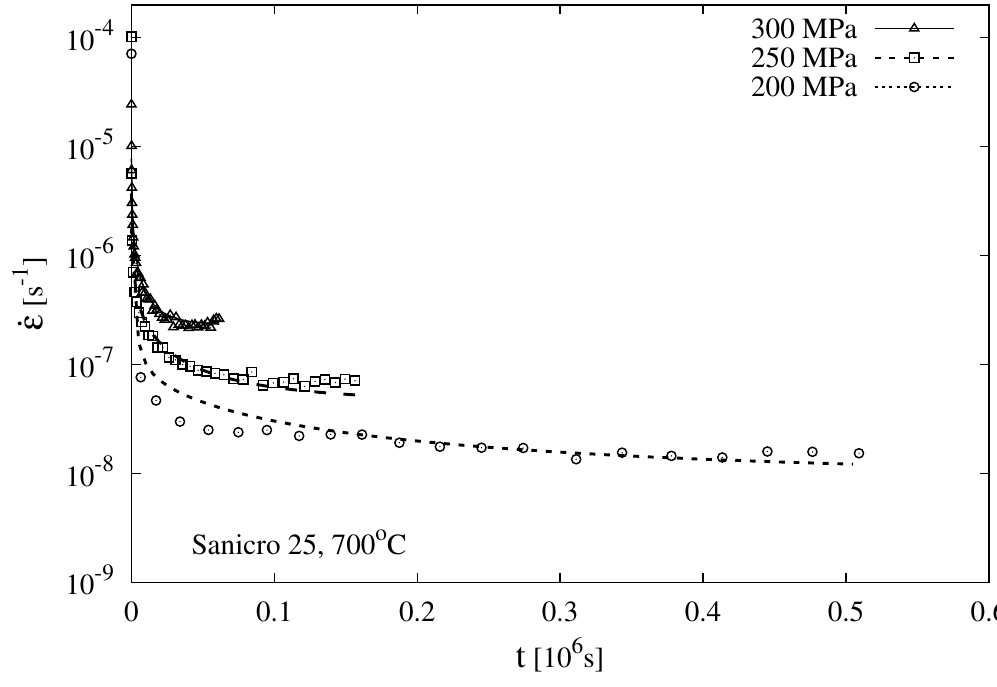
Figure 6. Creep rate dependence on time for Sanicro 25 at 700 ◦ C and high stresses [18] (points) compared to model results (lines).